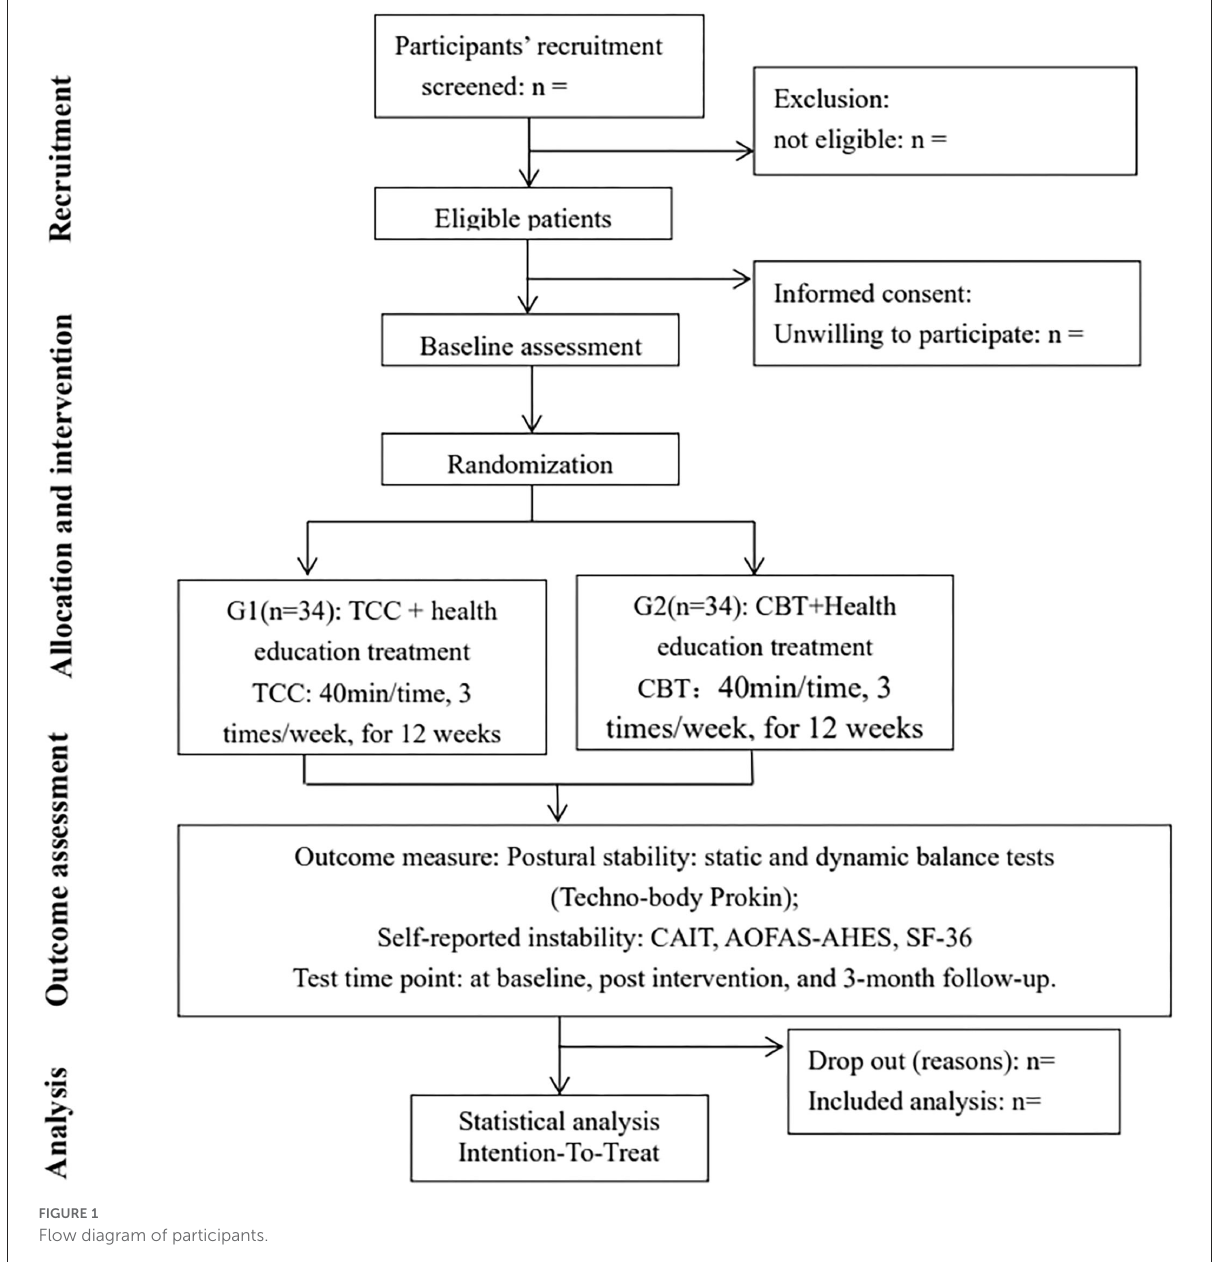
FIGURE1 Flow diagram of